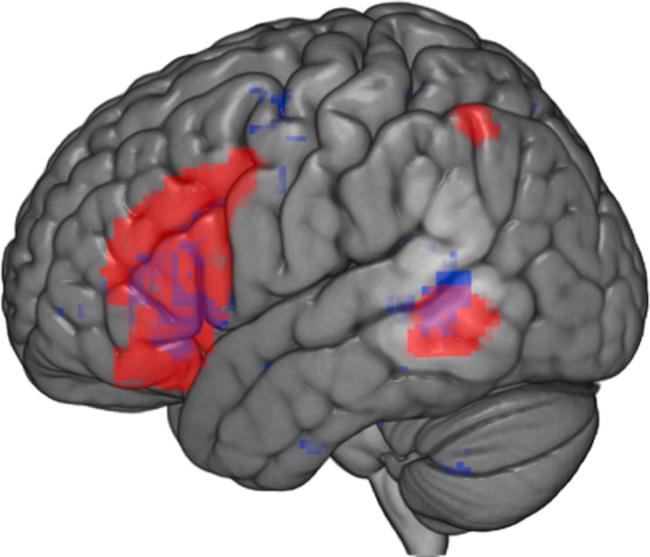
The brain regions in red show the semantic control network reported in the meta-analysis of Noonan et al., 2013. The verb and action knowledge map in blue are the results of an automated meta-analysis using Neurosynth.org (Yarkoni, Poldrack, Nichols, Van Essen, & Wager, 2011). This map shows the activation reported in 110 fMRI studies archived on the database, using “verb” as searching term. Purple shows regions in LIFG and pMTG where these meta-analyses for verb processing and semantic control overlap. The overlap in pMTG has been revealed more prominently by clipping off the cortex to reveal activation within the gyri. (For interpretation of the references to colour in this figure legend, the reader is referred to the web version of this article.)